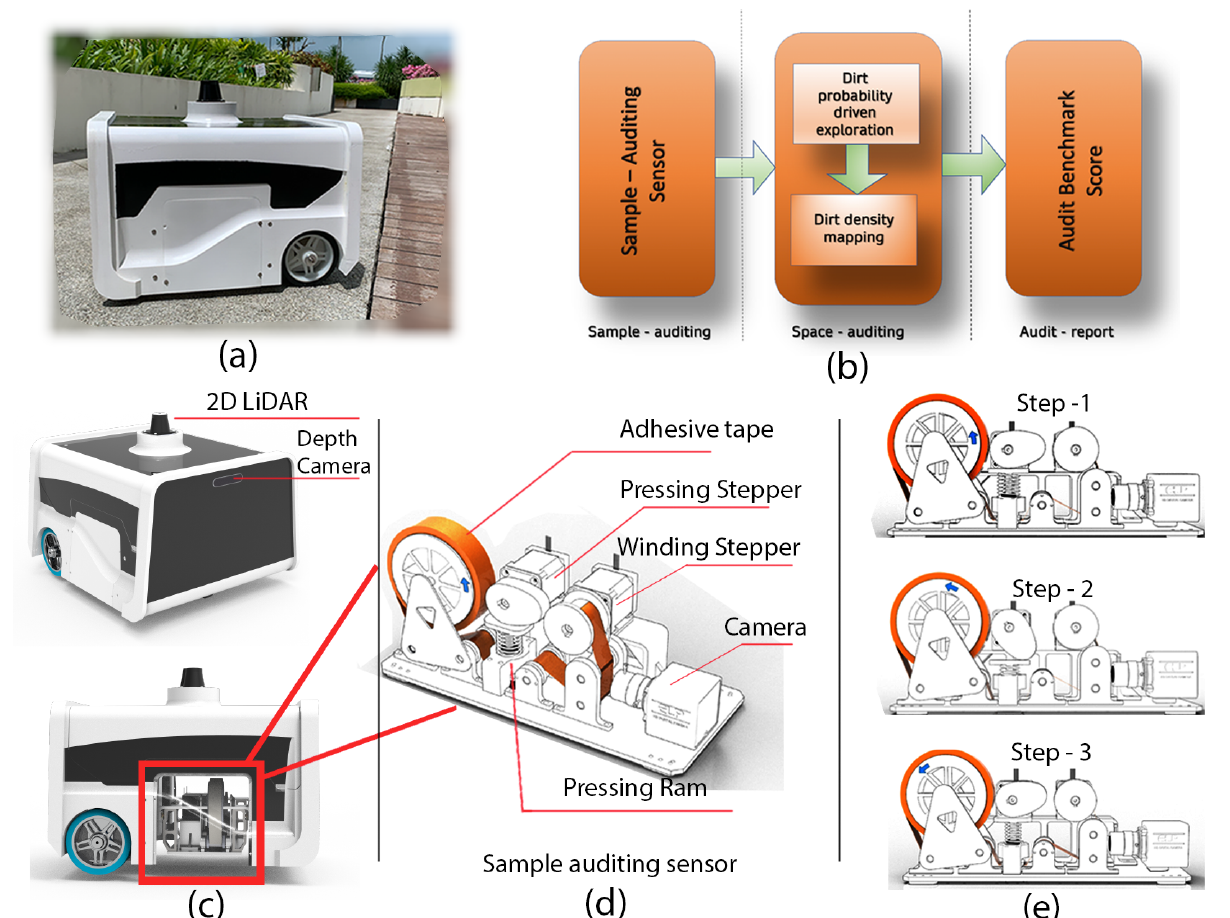
Figure 1. The components associated with autonomous cleaning-auditing , the BELUGA robot ( a ) , the cleaning-auditing framework ( b ), robot with navigation sensors and sample audit sensor ( c ), components inside the sample audit sensor ( d ), and the steps involved in sample auditing process ( e